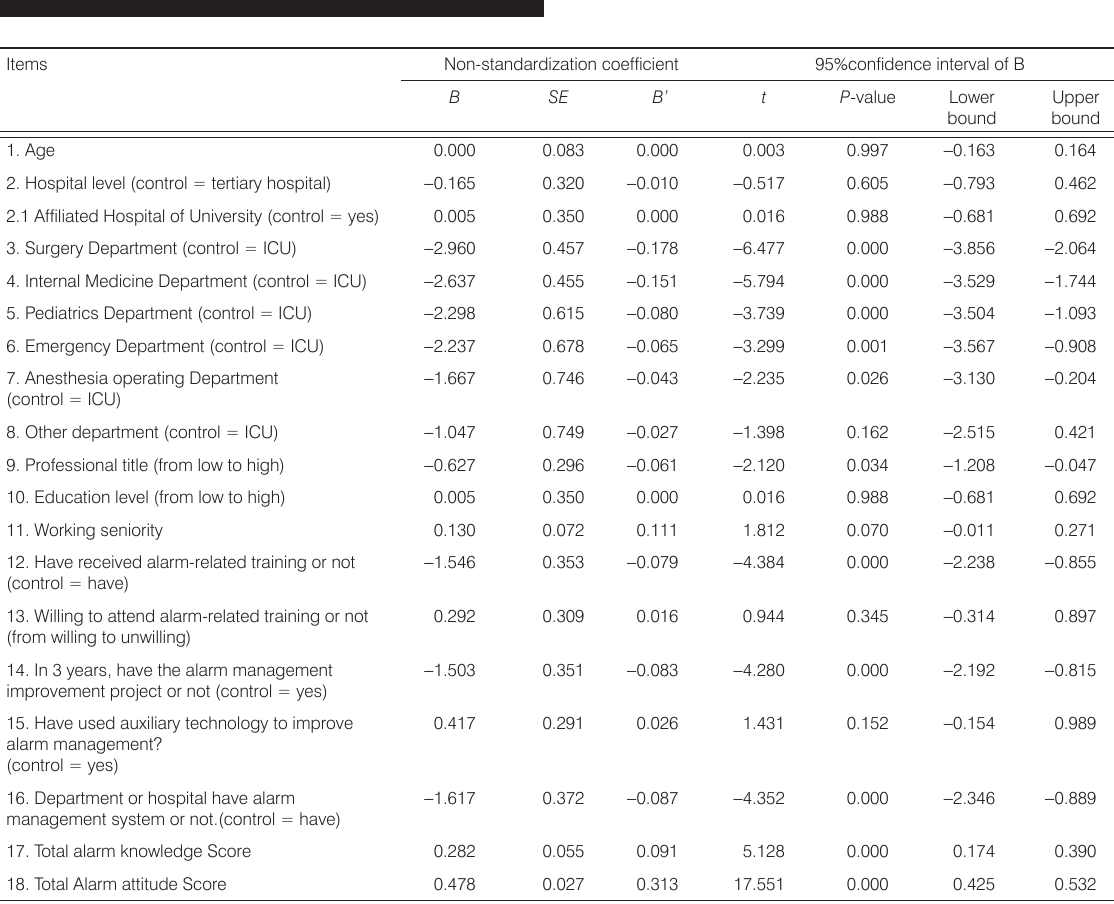
Table 5. Multivariate linear regression analysis of alarm behaviors and related